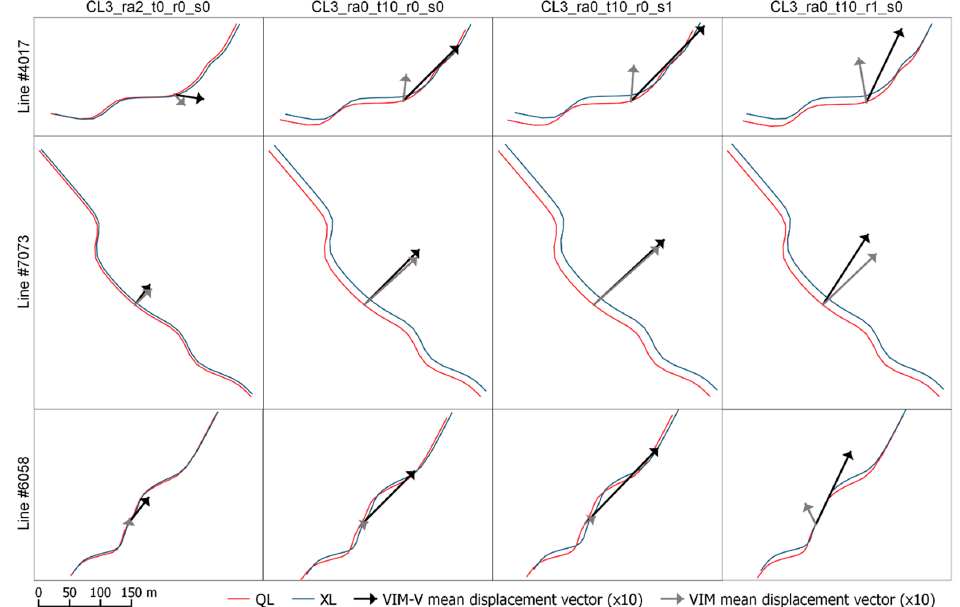
Figure 7. Examples of VIM-V and VIM displacement vectors on specific lines (vectors are multiplied by 10).